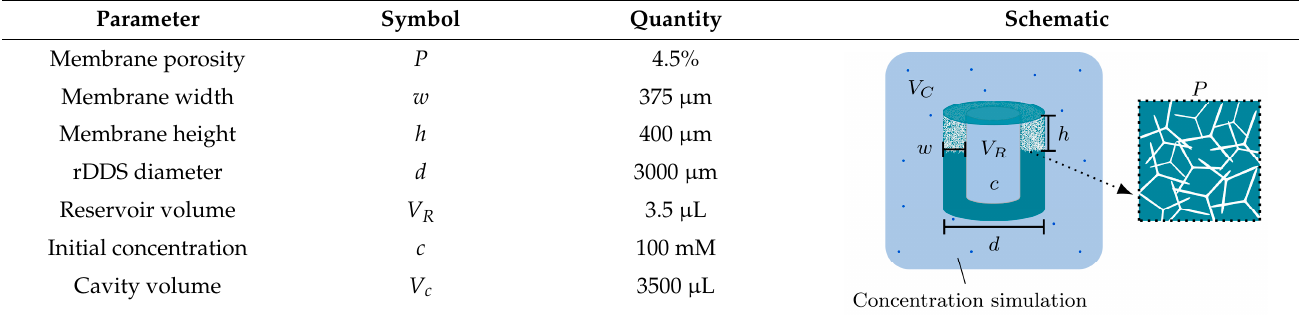
Table 1. Standard simulation setup.